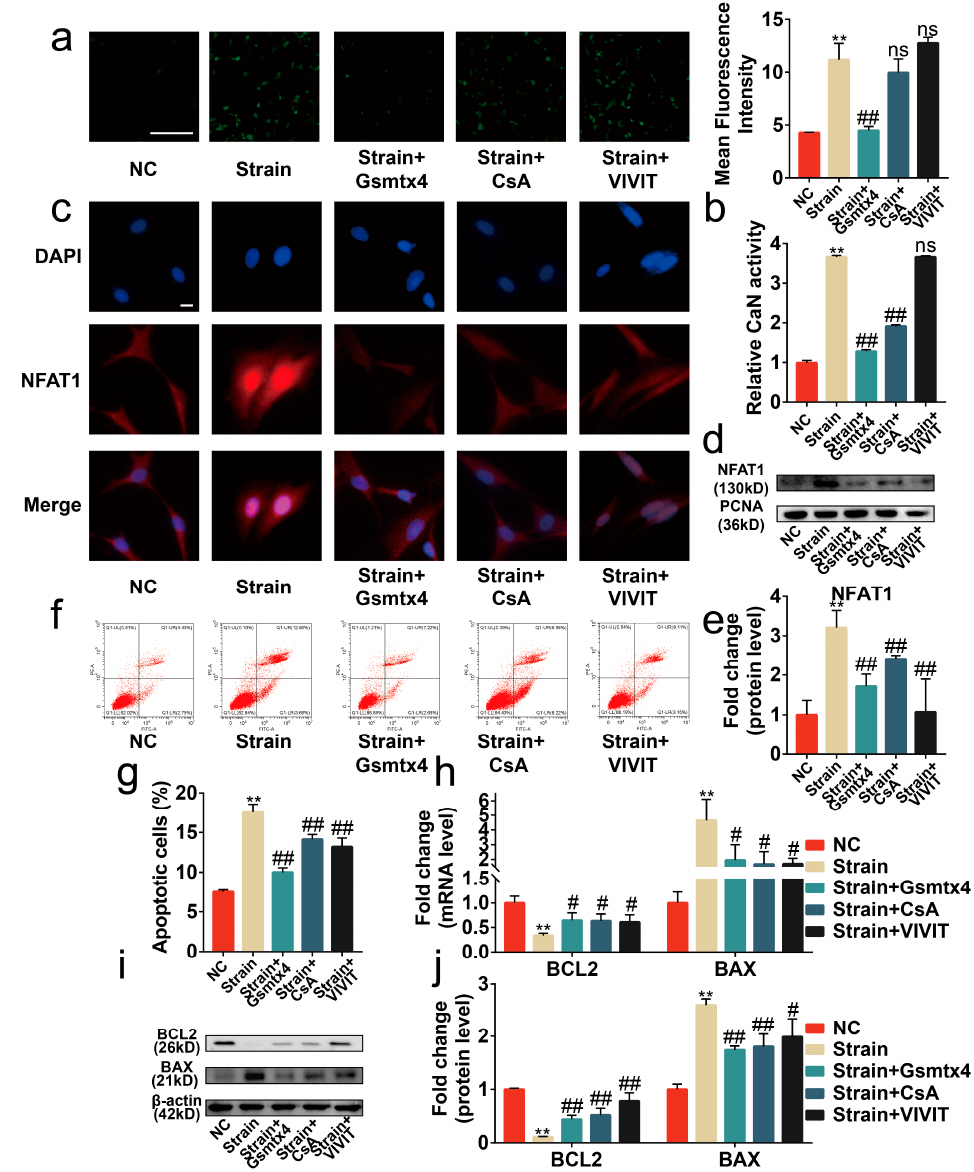
Figure 5. Blocking the signal transduction of the CaN/NFAT1 signaling axis protected chondrocytes from apoptosis. ( a ) Representative image of the Flou-4AM stain ( n = 3), scale bar: 100 µ m. ( b ) The activity of CaN is determined by the CaN Activity Kit ( n = 3). ( c ) Representative immunofluorescence image of NFAT1 nuclear translocation ( n = 3), scale bar: 10 µ m. ( d ) Western blot analysis of NFAT1 in chondrocyte nucleoprotein ( n = 3). ( e ) Quantified results of ( d ). ( f , g ) Flow cytometry analysis of chondrocyte stained with Annexin V-FITC and PI ( n = 3). ( h ) mRNA levels of BAX and BCL2 in chondrocytes determined by RT-qPCR ( n = 3). ( i , j ) Western blot analysis and quantified results of BAX and BCL2 ( n = 3). ** p < 0.01 vs. NC; # p < 0.05 vs. strain; ## p < 0.01 vs. strain; ns, no significant differences. One-way ANOVA with Bonferroni’s test for ( a , b , e , g , j ), Kruskal–Wallis test with Dunn’s multiple comparisons test for ( h ). Scale bar: 100 µ